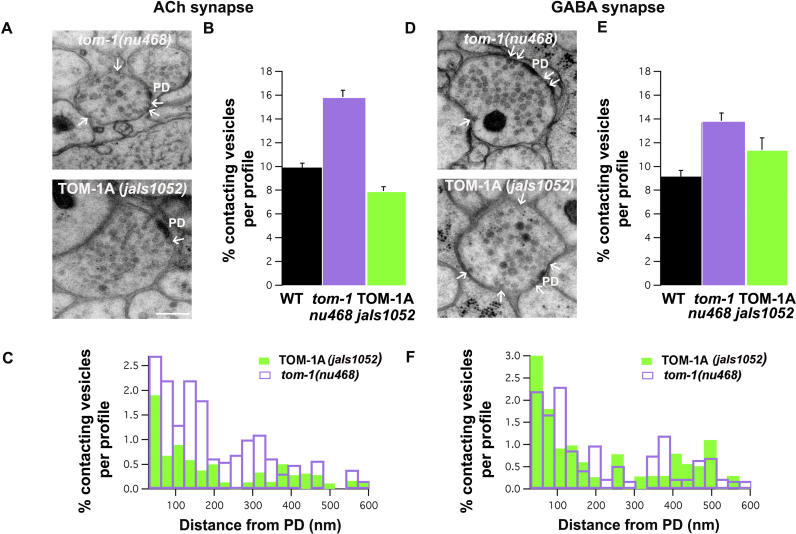
Comparison of the Plasma Membrane-Contacting Vesicles and Synaptic Vesicle Distribution in Cholinergic and GABAergic Synapses of WT,
tom-1(nu468), and TOM-1A–Expressing Animals (
jaIs1052)
(A) Representative images of cholinergic synapses in
tom-1(nu468) (top) and
jaIs52 (bottom), Scale bar = 200 nm.
(B) The ratio of the plasma membrane-contacting vesicles per profile is reduced in
tom-1(nu468) mutants expressing TOM-1A in cholinergic neurons (
jaIs1052) compared to both
tom-1(nu468) mutants and WT.
(C) The distribution of plasma membrane-contacting vesicles relative to the presynaptic density in cholinergic synapses of
jaIs1052 and
tom-1(nu468) animals, expressed in 30-nm bins as ratio of total vesicles per profile.
(D) Representative images of a GABAergic synapse in
tom-1(nu468) mutants (top) and
jaIs1052 (bottom).
(E) The ratio of plasma membrane-contacting vesicles is significantly increased in
tom-1(nu468) GABAergic synapses compared to WT, and is not rescued by expressing TOM-1A in cholinergic neurons.
(F) The distribution of plasma membrane-contacting vesicles relative to the PD are similar in
tom-1(nu468) and
jaIs1052 animals at GABAergic neuromuscular synapses. Data expressed as mean ± SEM.